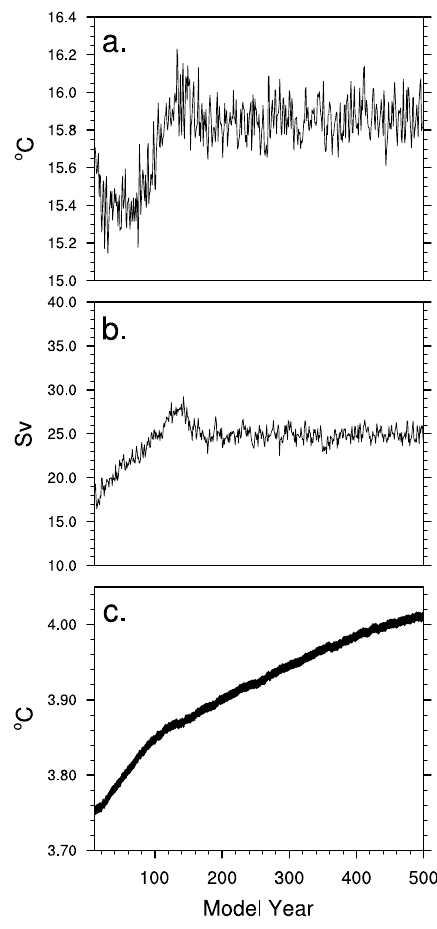
Fig. 2. Time series plots of simulated annual mPWP (a) global sur- face air temperature, (b) Atlantic meridional overturning circula- tion, and (c) volume-integrated, global ocean